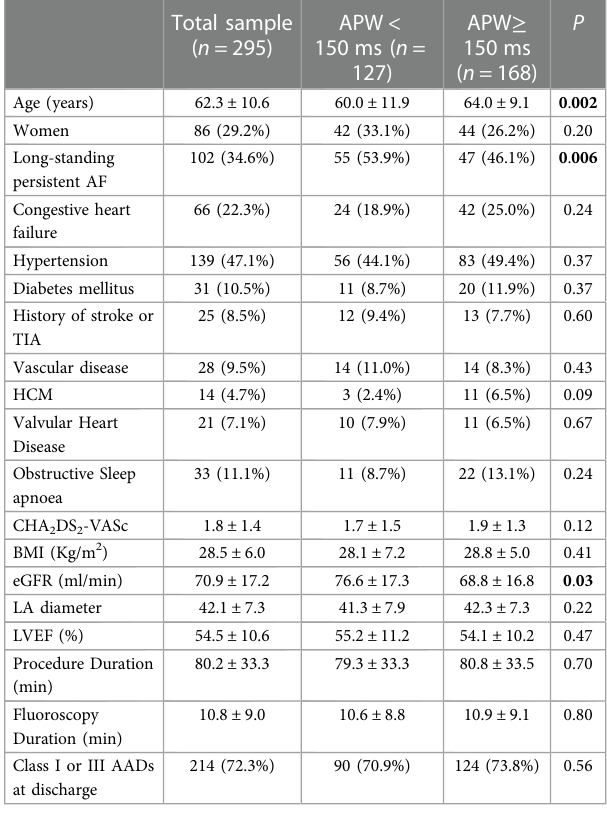
TABLE 1 Baseline characteristics of the study